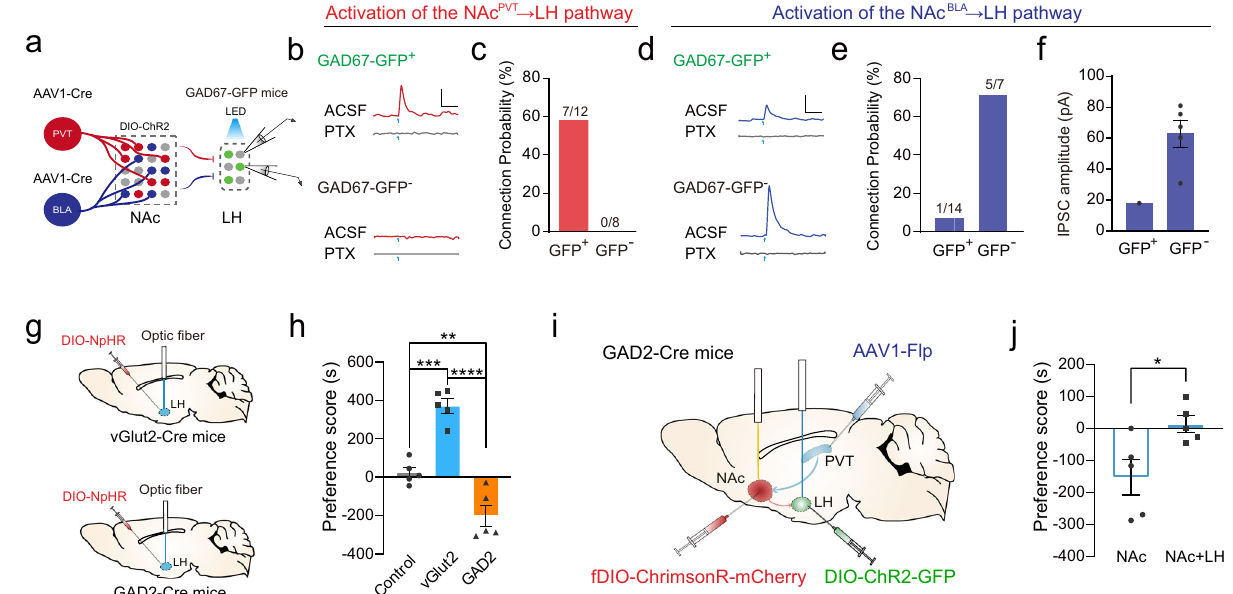
Fig. 7 | NAc PVT and NAc BLA neurons innervate different types of neurons in the LH. a Schematic showing the experimental design to record GABAergic neurons and putative glutamatergic neurons while stimulating NAc BLA or NAc PVT axonal terminal in LH slice from GAD67-GFP mice. b Example traces showing inhibitory postsynaptic current (IPSC) recorded from GFP-positive GABAergic neurons (up) and GFP-negative putative glutamatergic neurons (bottom) in the LH following briefopticalstimulationofNAc PVT terminalsintheLH,withorwithoutthepresence of picrotoxin (100mM). Scale bar: 20pA, 100ms. c Probability of synaptic con- nectionbetweenNAc PVT withGFP-positive( n =12)andGFP-negative( n =8)neurons in the LH. d Example of traces showing inhibitory postsynaptic current (IPSC) recorded from GFP-positive GABAergic neurons (up) and GFP-negative putative glutamatergic neurons (bottom) in the LH following brief optical stimulation of NAc BLA terminals in the LH, with or without the presence of picrotoxin (100mM).